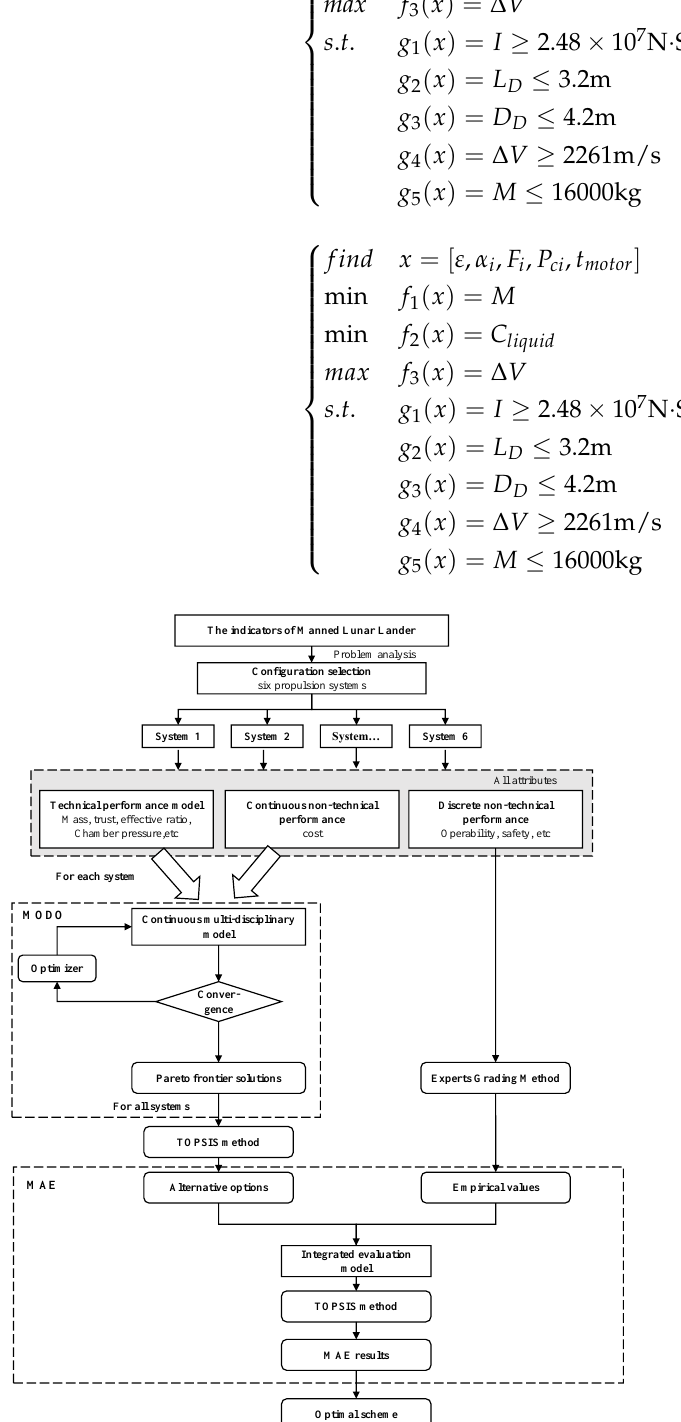
Figure 7. The process of MODO and MAE.